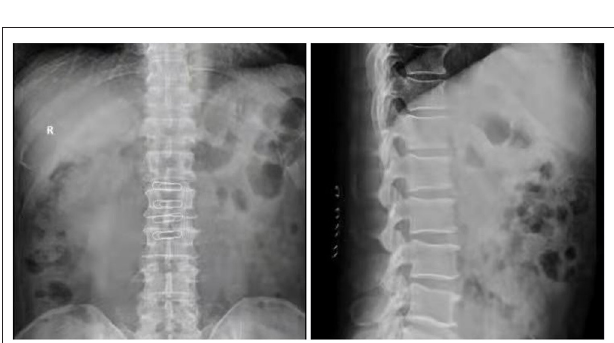
FIGURE 4 | Position the cone preoperatively of the case